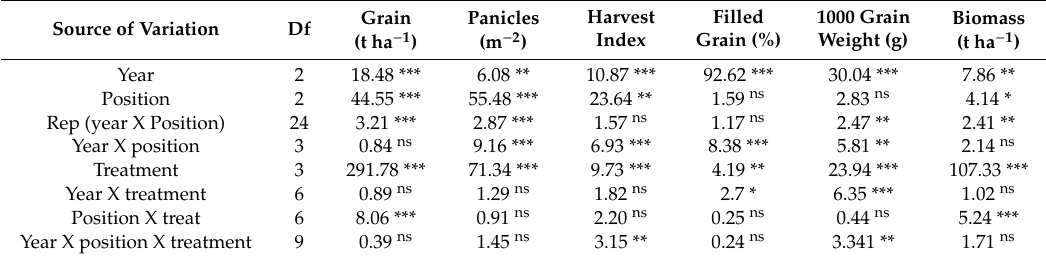
Table 3. Analysis of variance (F values) of the e ff ect of year, position and treatment on rice grain yield, panicles, harvest index, % filled grain, 1000 grain weight and dry biomass production.